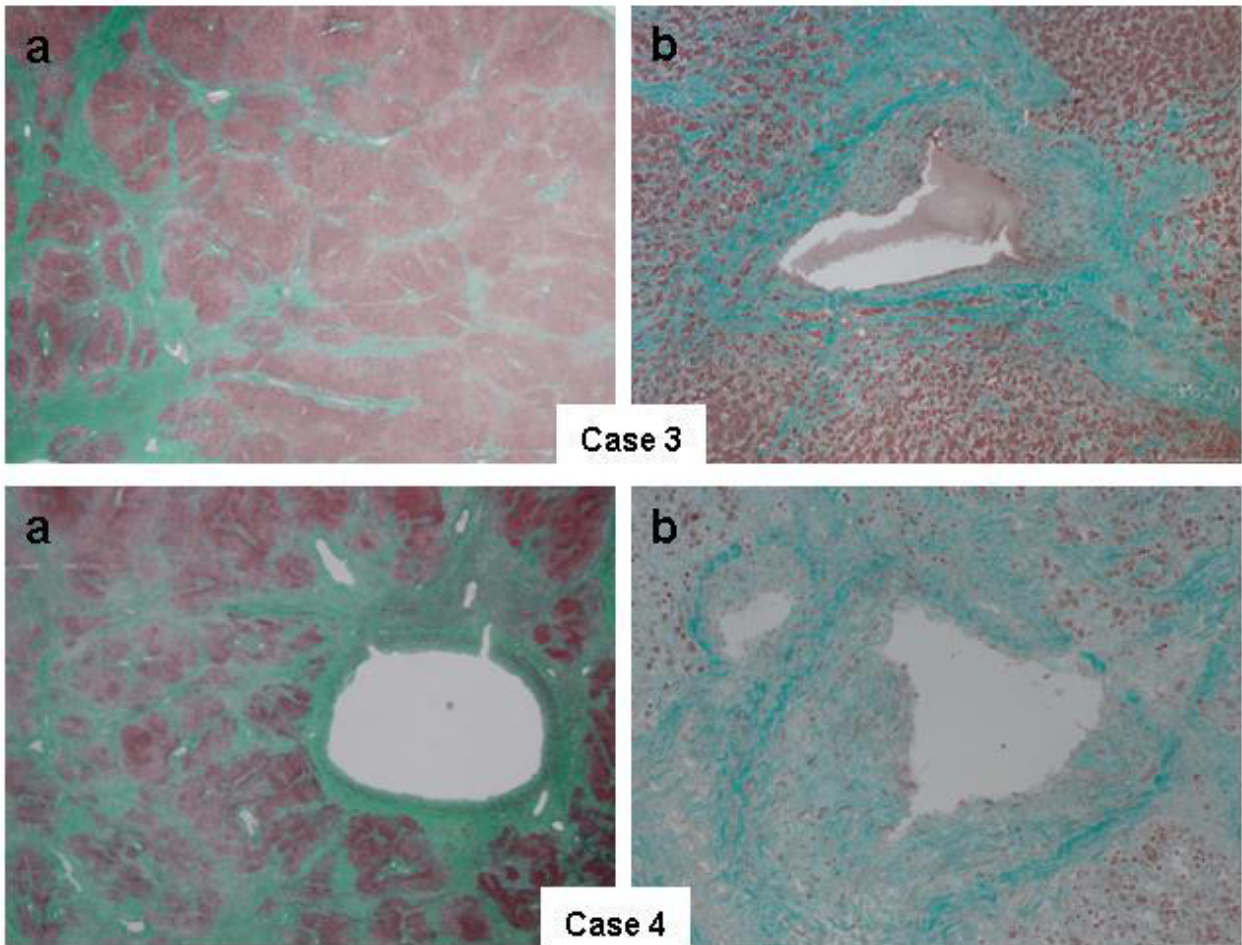
Figure 1. Liver histopathology obtained at autoptic examination by Masson’s Trichromic staining: ( a ) a panoramic view ( × 10 magnification) and ( b ) close up view ( × 40 magnification). In particular, the marked distortion of the liver structure, with fibrotic bridges arising from centrilobular veins and involving sinusoidal spaces and portal tracts, can be seen. Note the increasing thickness of fibrotic septa from Cases 1 to 4, so as to manifest the characteristic condition of “reverse cirrhosis”; moreover, in Case 4, the presence of cholestasis also resembles the so called “nutmeg pattern”. Table 2 details the pathological features and the cause of death for the reported